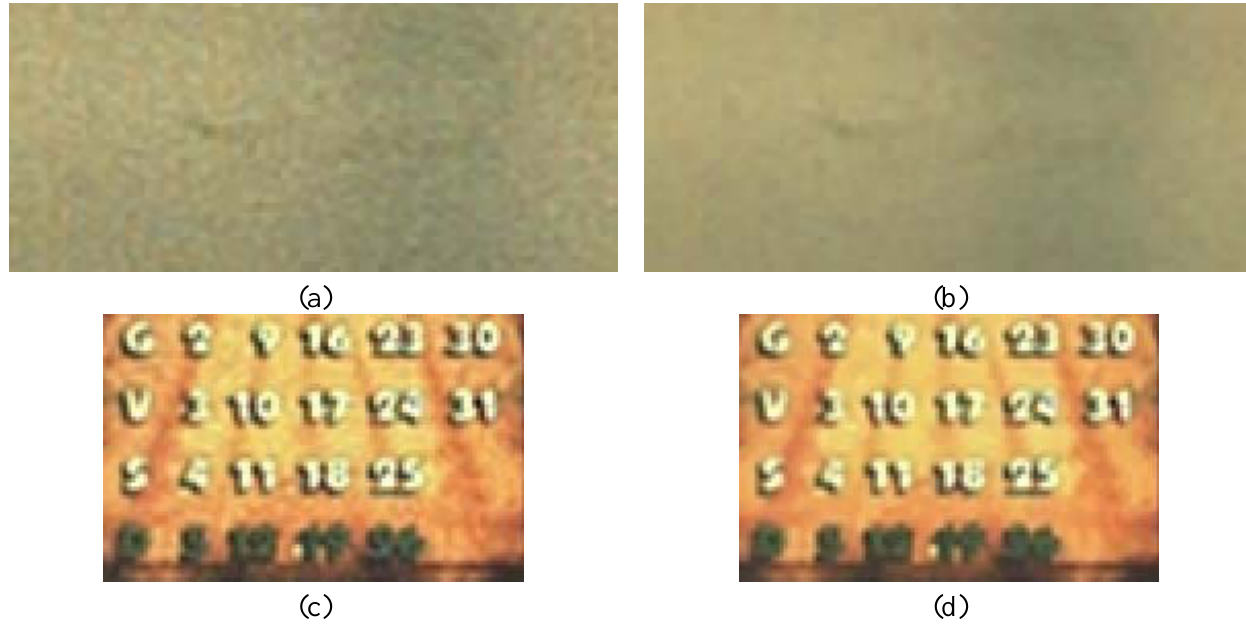
Figure 17. Magnified details of Figure 14(b). (a) 200% zoomed (pixel resize) cropped part of noisy image. (b) Filtered 200% zoomed (pixel resize) counterpart (c) 200% zoomed (pixel resize) cropped part of noisy image. (d) Filtered 200% zoomed (pixel resize) counterpart. The effects of the proposed method over flat (a), (b) and textured (c), (d) areas are shown. The noisy images are obtained by color interpolating unfiltered Bayer data (a), (c). The corresponding color images produced by demosaicing filtered Bayer data (b), (d). SNR values are: 47.2dB for noisy image and 51.8dB for filtered image.